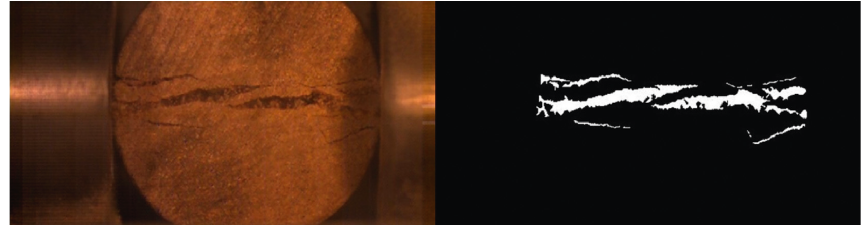
Figure 4: Labeling result for rock